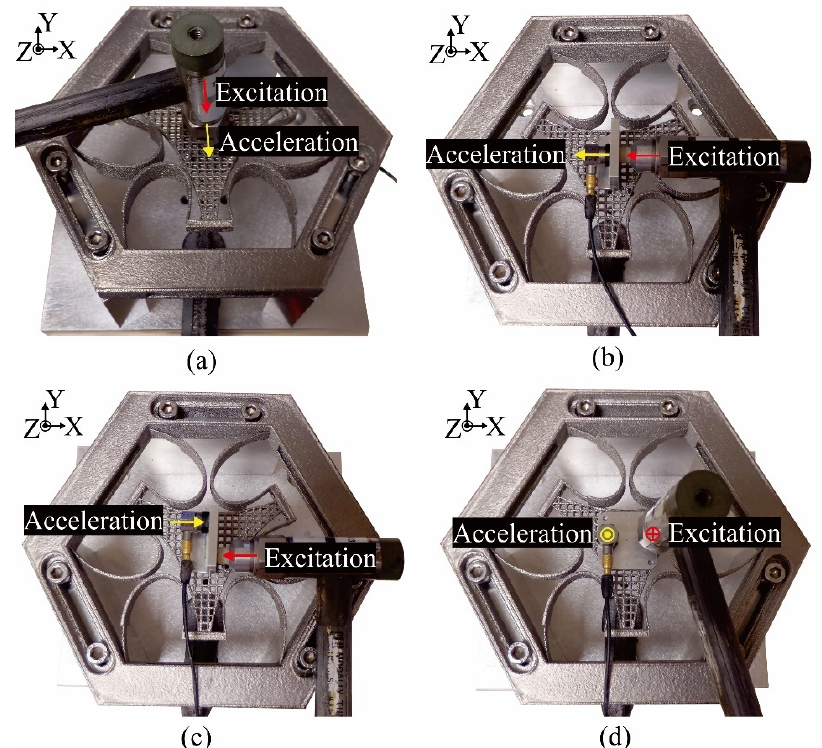
Figure 10. Experimental setup to measure the dynamic response: ( a ) along the Z axis; ( b ) along the X axis; ( c ) about the Z axis; ( d ) about the Y axis.